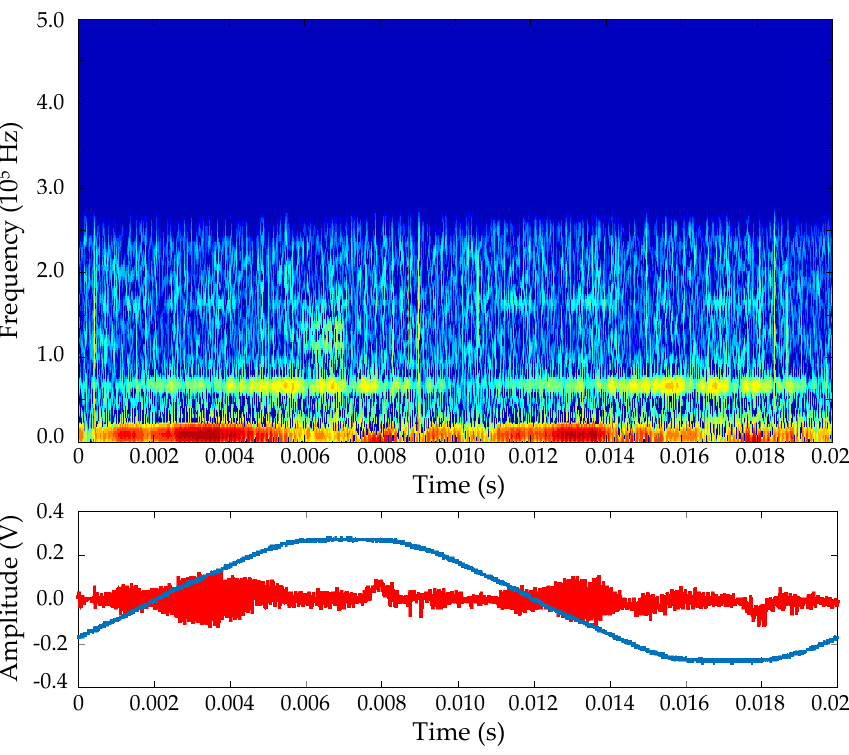
Figure 15 . Noise at the urban dense 1 site.